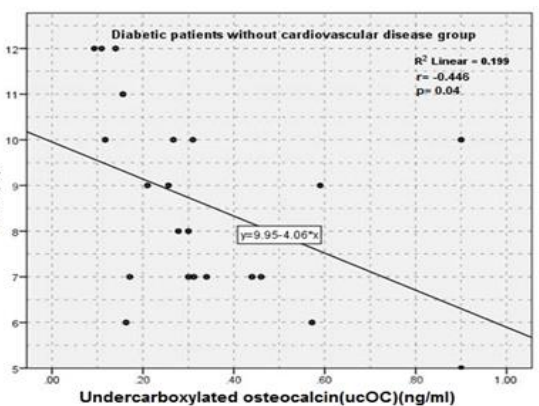
Figure 5. Correlation between undercarboxylated osteocalcin (ucOC) (ng/ml) and HbA 1c in diabetic patients without cardiovascular disease group.